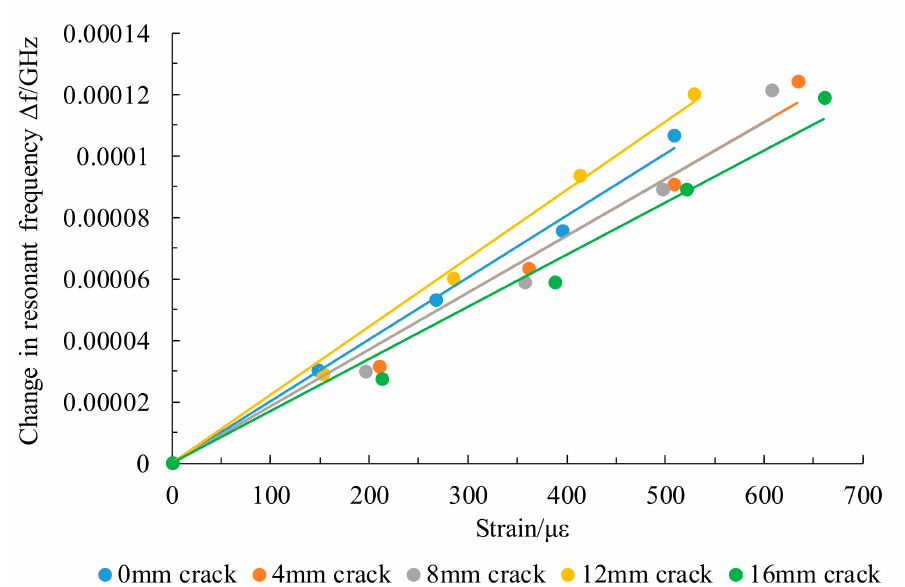
Figure 18. Relationship between resonant frequency and strain for the underlying patch during crack